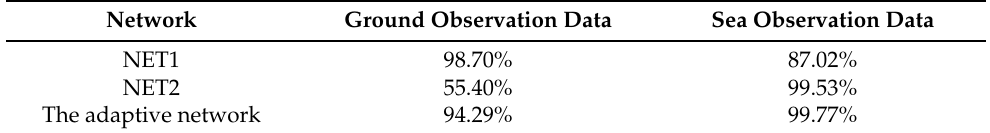
Table 3. Target detection probability of each network.